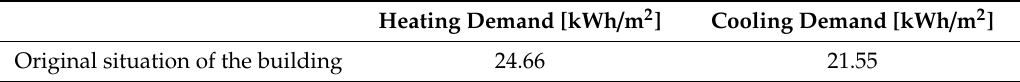
Table 3. Heating and cooling demand of the